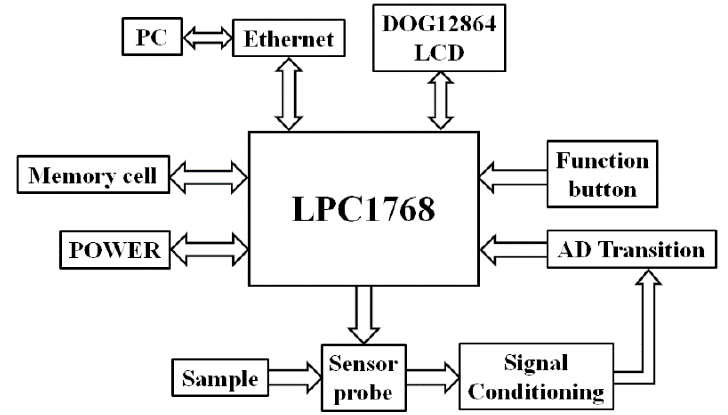
Figure 4. The block diagram of hardware design.